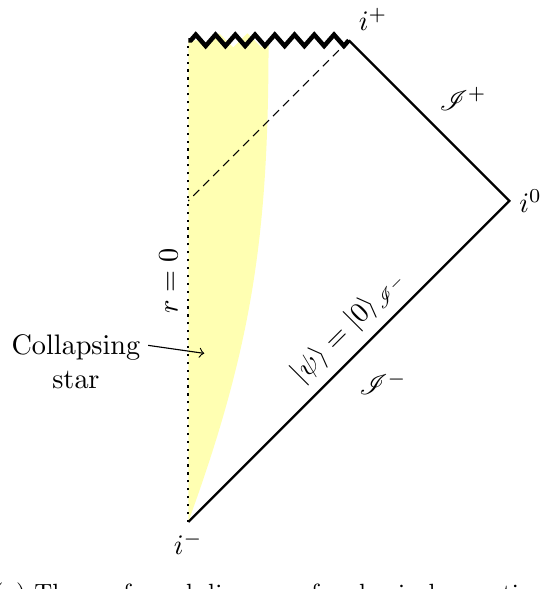
(a) The conformal diagram of a classical spacetime (b) An illustration of the backwards- describing collapse of matter (a ‘star’) to form an propagation of a mode localized at late asymptotically flat black hole with a single asymp- retarded-time on I + . totic region. Figure 2. The final event horizon H + is shown as a dashed line, and the singularity as a jagged line. Future and past null infinity are labelled by I ± . The vertical line marked r = 0 is a regular origin of spherical polar coordinates. The state is chosen as the vacuum of quantum fields in the flat asymptotic region I − , thus | ψ i = | 0 i I − . In the shaded region of (b) near I + , our spacetime is nearly stationary. There, the backwards-propagation reduces to scattering in a fixed potential and results in a transmitted part T and a reflected part R . For modes localized at late (retarded) times on I + , the reflected part R will remain in the nearly stationary region and transmitted part T will be localized very close to H + . In particular, the wavelength of T becomes very short in the reference frame shown. This allows us to complete the backwards-propagation of T from the near-horizon region to I − using geometric